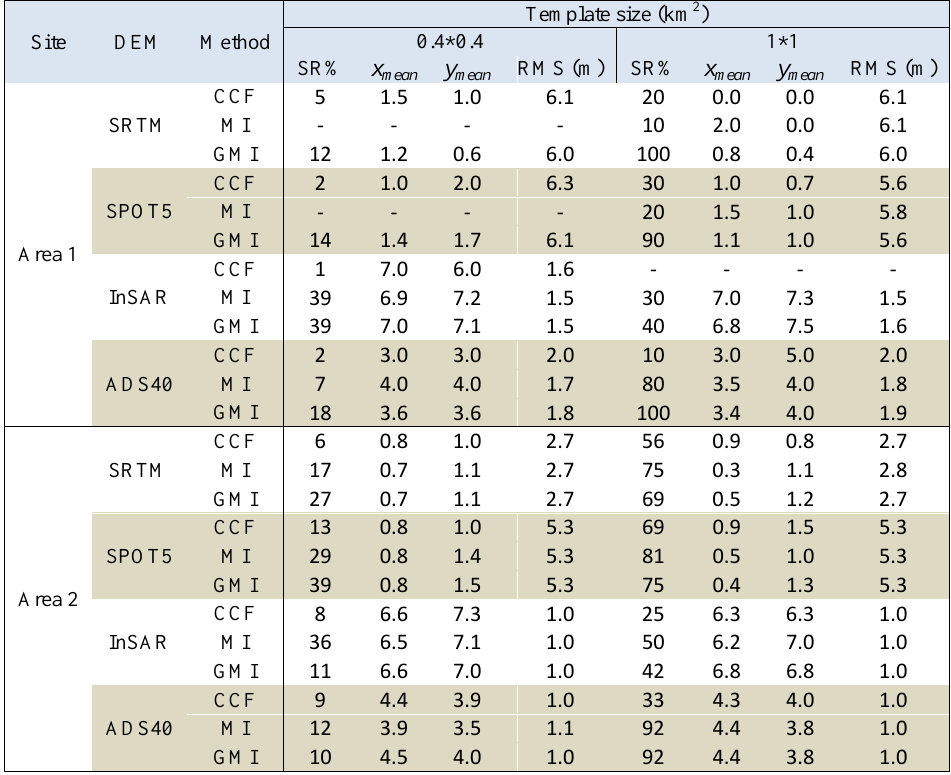
Table 2. Accuracy evaluation results against the reference DEM after the registration. SR% indicates the success rate, x mean and y mean are the computed translations in pixels, and RMS is the root mean square height discrepancy value after